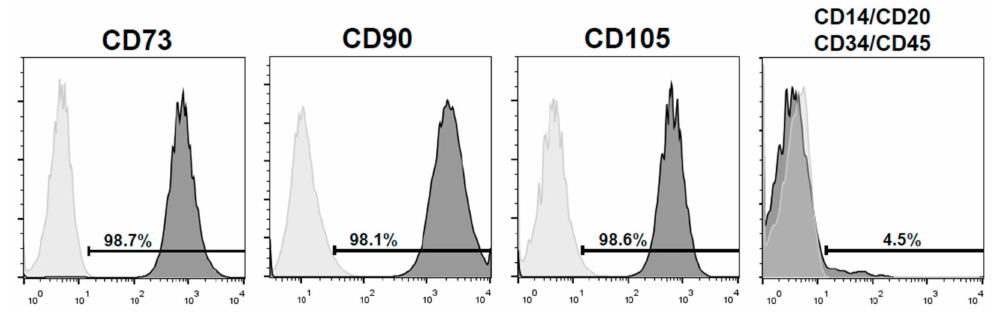
Figure 1. Positive expression ( > 95%) of mesenchymal stem cells markers CD90, CD73, and CD105, and negative expression for markers CD14, CD20, CD34, and CD45 ( < 5%). Control isotypes’ staining is also shown.